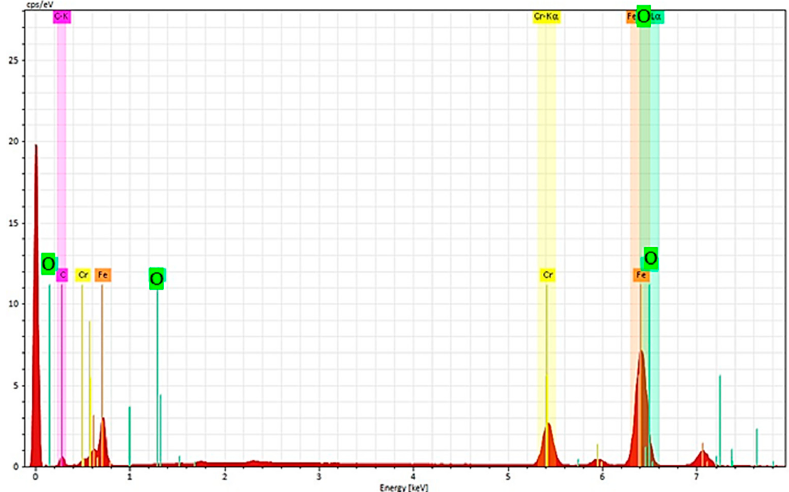
Figure 14. EDS-SEM analysis composition of the non-used Figure 14. EDS ‐ SEM analysis composition of the non ‐ used drills.